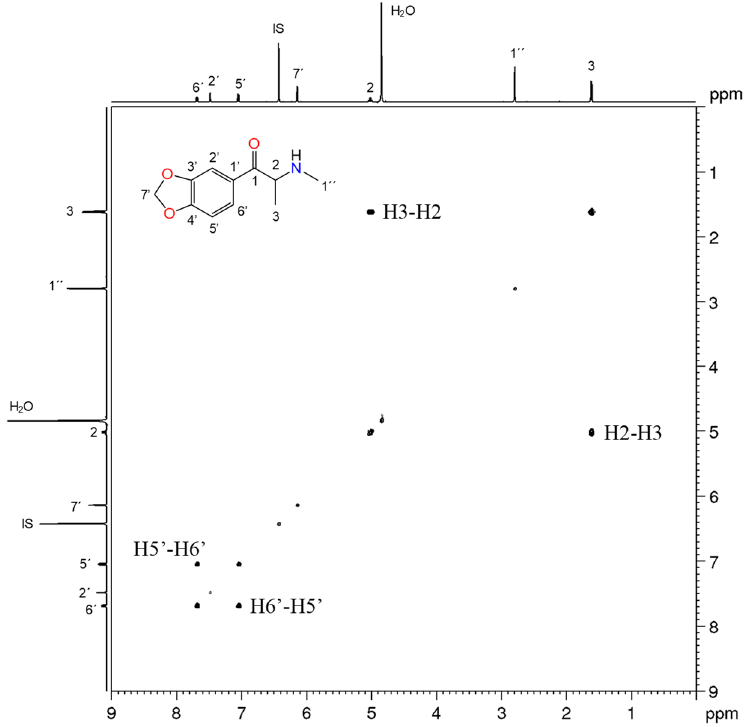
Figure 7. 1 H- 1 H COSY NMR spectrum of methylone found in product 10. Analytical data for products 3–7 revealed the presence of methedrone together with other cathinones, namely N -ethylcathinone and buphedrone. Methedrone is a methcathi- none derivative only differing by the presence of a methoxy group in the para position of the aromatic ring. Hydrogens belonging to the methoxy group were identified in the 1 H NMR spectrum as a singlet at 3.48 ppm, while the proton attached to chiral carbon (H-2) was identified as a quartet at 5.11 ppm, which are in accordance with the results obtained by Zancajo et al. [50]. An apparent triplet at 8.04 ppm (due to overlap with buphedrone and N -ethylcathinone signals) and a doublet at 7.14 ppm, with coupling constants of 8.84 Hz and 8.96 Hz, supported substitution in para position. The methyl groups H-3 and H-1 (cid:48)(cid:48) produce a doublet at 1.64 ppm, and a singlet at 31.6 ppm,